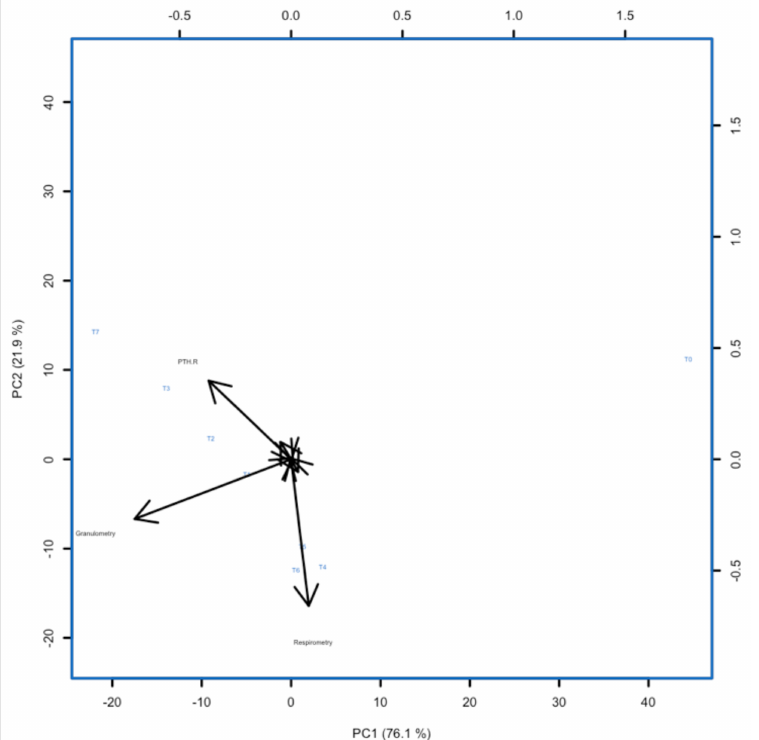
Figure 5. PCA Analysis. T0: Soil without treatment; T1, T2, and T3: soils treated with lime at 1, 2, and 3%, respectively; T4, T5, and T6: soils treated with 40 nm silica nanoparticles at 0.5, 1, and 2% respectively; T7: soil treated with 0.5% nanosilica and 2%